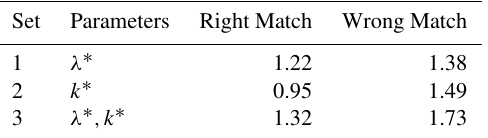
Table 1. Analyzed configuration sets with their associated uncer- tain parameters and χ 2 values for two scenarios: the first one with the right match between the constitutive law that generates the syn- thetic measurements and the ensembles, and the second one with the wrong match.